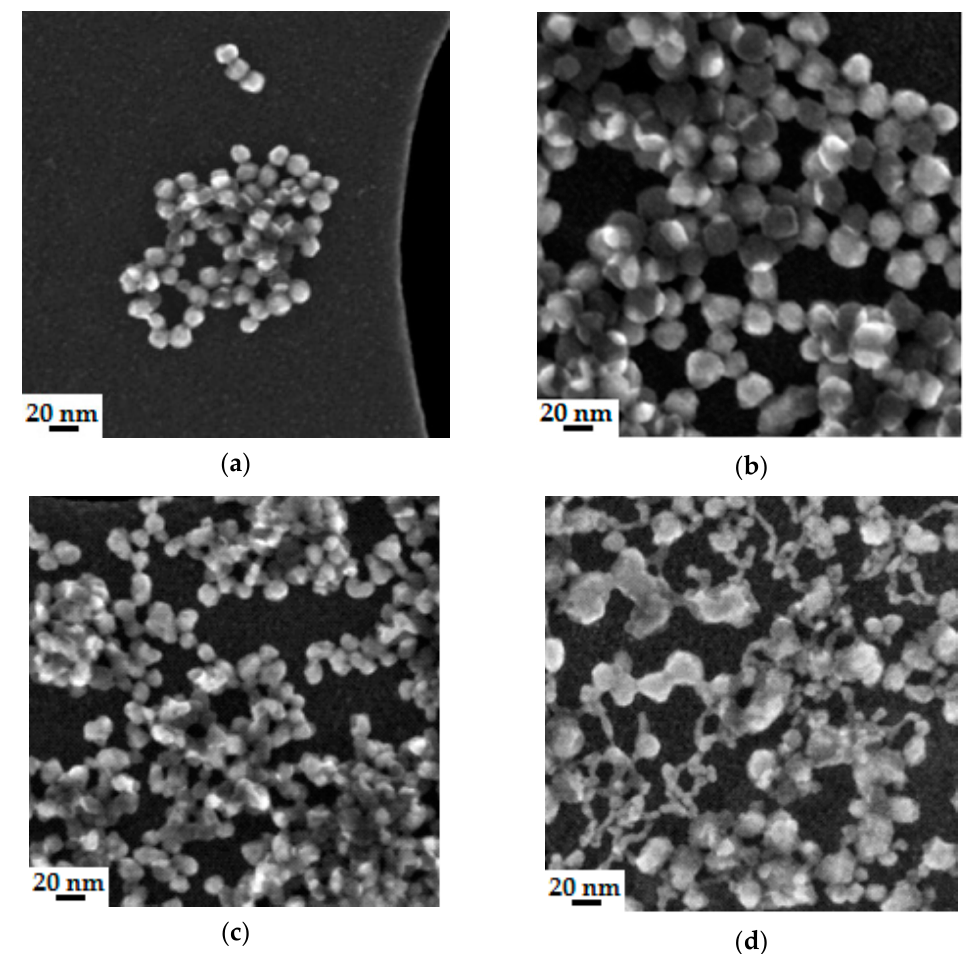
Figure 11. Morphology of nano-SiO 2 in the binders: ( a ) LUDOX SK, ( b ) LUDOX AM, ( c ) REMASOL, ( d ) EHT.